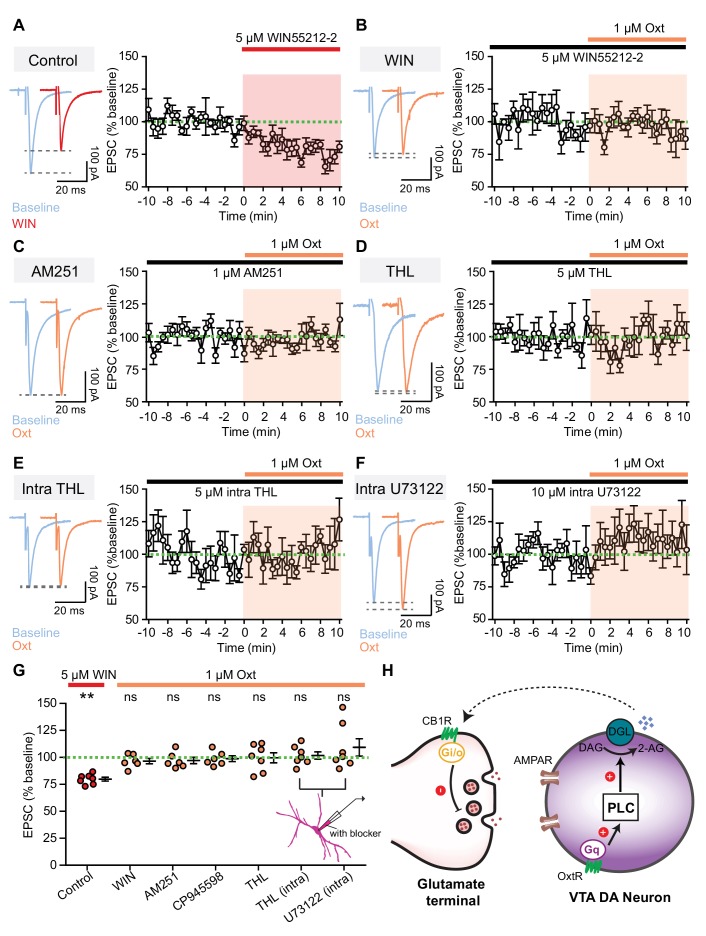
Retrograde endocannabinoid signaling underlies oxytocinergic modulation of excitatory synaptic transmission.(A) Left: example traces of evoked EPSCs from one VTA DA neuron during baseline and following 5 μM CB1R agonist WIN55212-2 application. Right: summary data for EPSC amplitude over time, normalized to baseline. (B) Left: example traces of evoked EPSCs from one VTA DA neuron during baseline and following 1 μM oxytocin application in the presence of CB1R agonist WIN55212-2. Right: summary data for EPSC amplitude over time, normalized to baseline. (C) Same as (B), but in the presence of CB1R inverse agonist AM251. (D) Same as (B), but in the presence of orlistat (THL), a blocker of 2-AG synthesizing enzyme diacylglycerol lipase α (DGLα). (E) Same as (B), but with THL in the internal solution to block 2-AG synthesis. (F) Same as (B), but with U73122 in the internal solution to inhibit PLC activity. (G) Summary data for EPSC amplitude changes induced by CB1R agonist WIN55212-2 and oxytocin in the presence of WIN55212-2, CB1R inverse agonist AM251, CB1R antagonist CP945598, orlistat (THL), intracellular THL, and intracellular U73122, separately. **p<0.01, Wilcoxon signed rank test vs. baseline. For each condition respectively, n = 7 neurons from five mice, six neurons from four mice, six neurons from three mice, six neurons from four mice, six neurons from four mice, seven neurons from four mice, and seven neurons from four mice. Error bars reflect SEM. (H) Schematic summary of the mechanism underlying direct oxytocinergic regulation of excitatory synaptic transmission in VTA DA neurons. Oxytocin binds to Gq-coupled OxtR, activating the phospholipase C (PLC) pathway. PLC cleaves phosphatidylinositol 1,4,5-bisphosphate into diacylglycerol (DAG) and inositol 1,4,5-trisphosphate, and DAG is subsequently converted into 2-AG by DAG lipase (DGL). 2-AG released by VTA DA neurons binds to presynaptic Gi/o-coupled CB1R, decreasing glutamate release.10.7554/eLife.33892.013Figure 3—source data 1.Summary tables of evoked EPSC amplitudes in response to endocannabinoid-signaling related pharmacological agents.